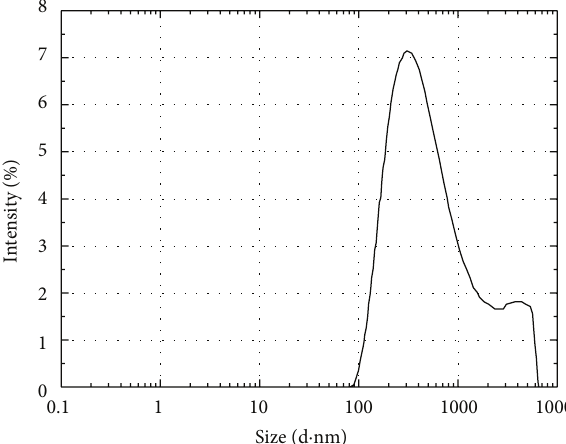
Figure 13: The particle size distribution curve of DPG after high- temperature